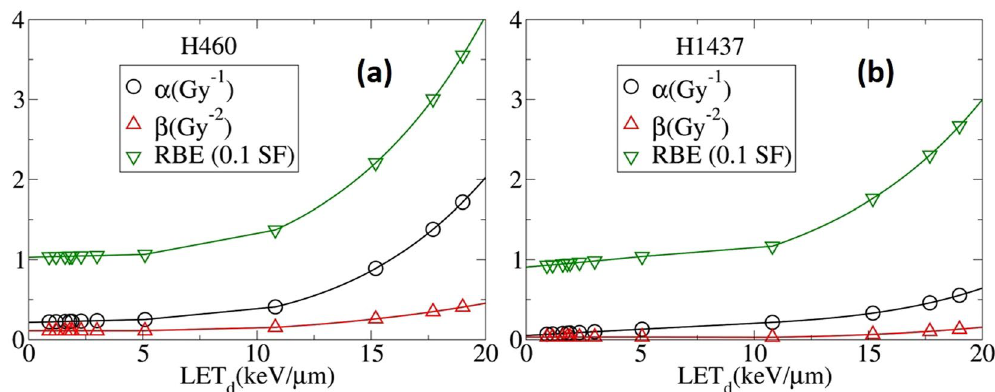
Figure 7. α , β , and RBE as a function of LET calculated analytically from SF equations obtained by the 3D global fitting of clonogenic cell-survival data as shown in Figs 2 and 3.